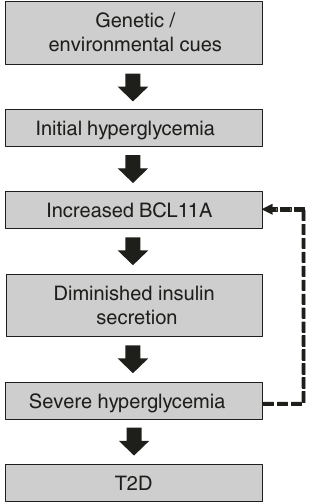
Fig. 6 Role of BCL11A in T2D pathogenesis and beta cell function. Schematic diagram describing the role of BCL11A in human beta cell dysfuction and the pathogensis of